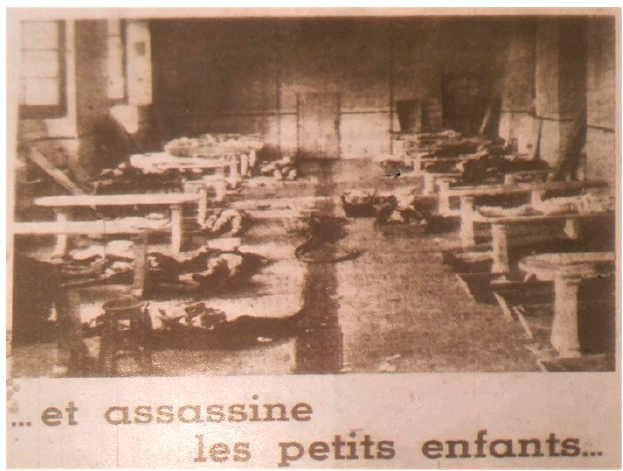
Figure 15. “… and assassinate the little children.” Paix et Liberté. 17 January 1938. Photograph. Bibliothèque Nationale de France.